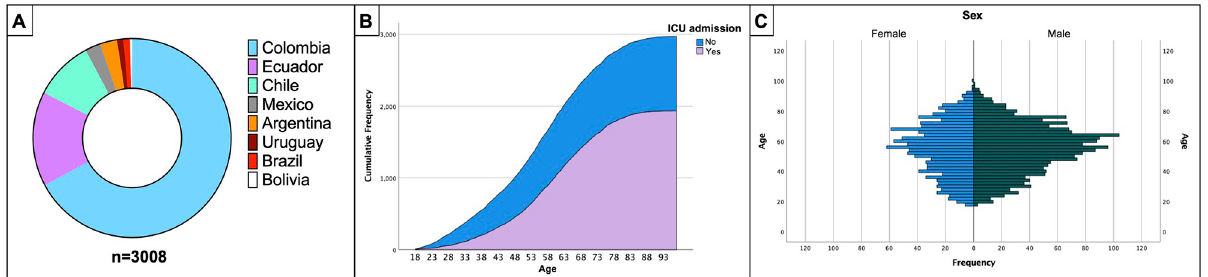
Fig 1. Older patients get sicker and have a higher cumulative frequency of ICU admission. (A) The proportion of patients enrolled in the study per country. (B) The figure presents the cumulative number of cases included in the study; in purple, patients admitted to the Intensive Care Unit (ICU) and patients with no admission to the ICU in blue. (C) The age distribution of subjects in the study is shown in this figure. Age ranges are listed down the center of the graph, and sex distribution is displayed on each